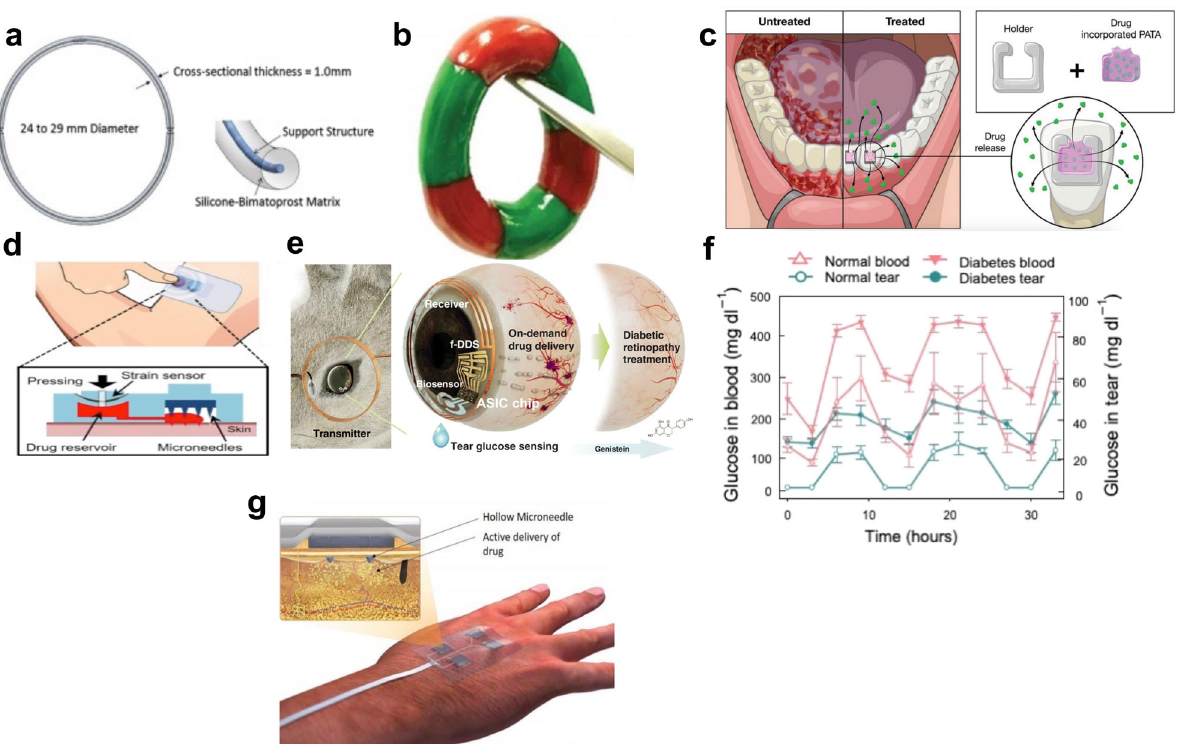
Fig. 6 HWDs for drug delivery. a Ocular Ring for the treatment of glaucoma. Reproduced with permission from Brandt et al. 101 Copyright © American Academy of Ophthalmology, 2017. b Self-healable gum made from PATA biomaterial. c Gum, as illustrated in b , fi lled with a drug and treated in an oral cavity. Reproduced with permission from Al-Shahbazi et al. 104 Copyright © Journal of Materials Chemistry B, 2020. d Working principle of touch actuated transdermal drug delivery. Reproduced with permission from Kim et al. 105 Copyright © Sensors and Actuators, 2018. e Smart contact lens for diabetic retinopathy therapy by detecting glucose level. f comparison of glucose levels in blood and tear for normal and diabatic person. Reproduced with permission from Keum et al. 97 Copyright ©, Science Advances, 2020. g Working principle of wirelessly controlled smart bandage. Reproduced with permission from Derakhshandeh et al. 108 Copyright ©, Advanced Functional Materials,